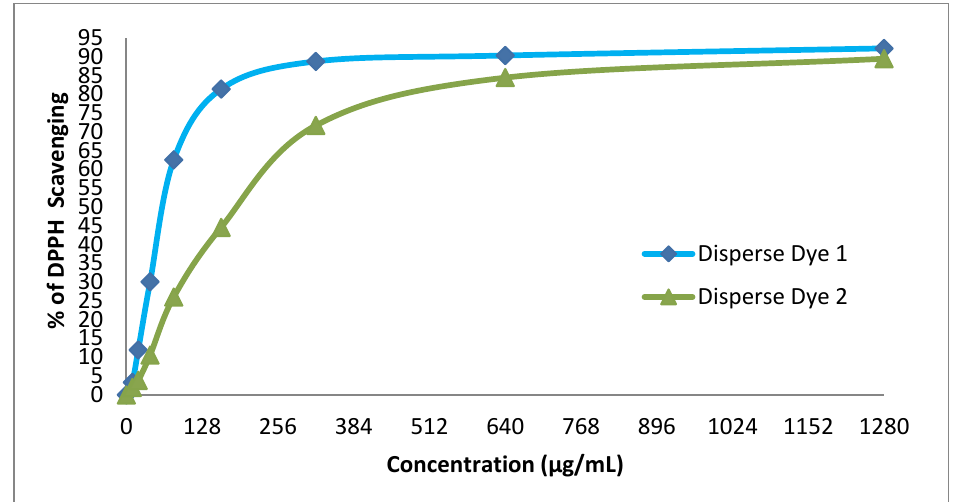
Figure 4. Evaluation of the antioxidant effect of disperse dyes 1 and 2.